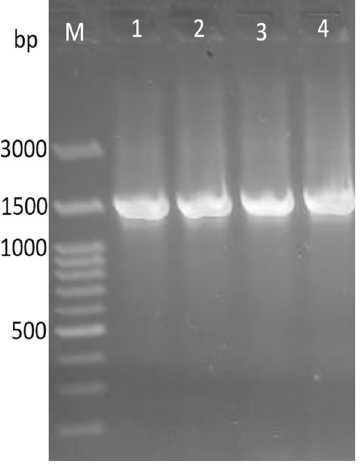
Fig. 1 Photograph of 16S-rDNA gene amplified band for the both bacterial strains using 16S primers against 100 bp ladder DNA